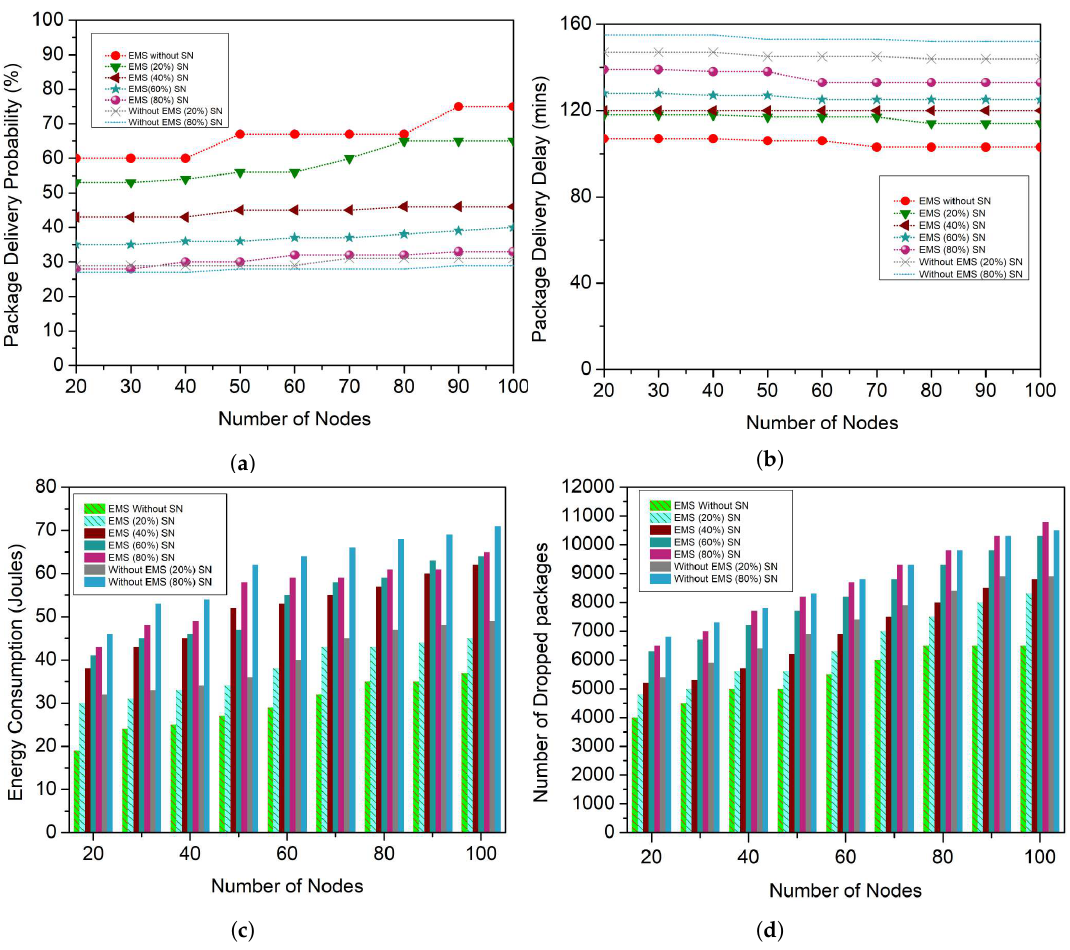
Figure 5. Impact of a Varying Number of Selfish Nodes. ( a ) Package Delivery Probability; ( b ) Package Delivery Delay; ( c ) Energy Consumption; ( d ) Number of Dropped